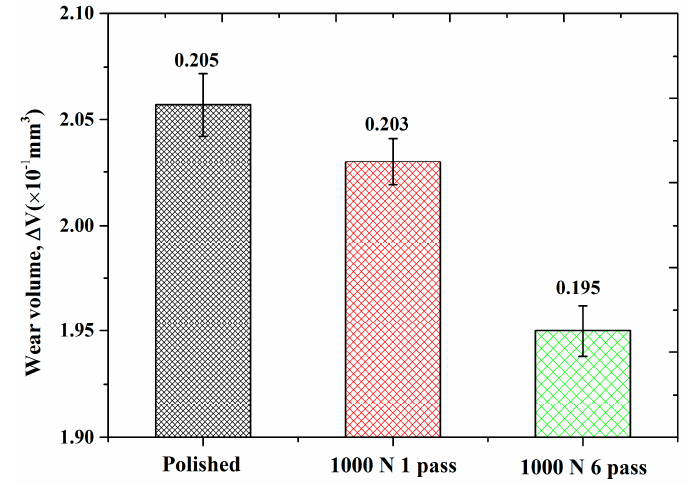
Figure 7. Wear volumes of SLM Ti-6Al-4V samples vs. different pass numbers.